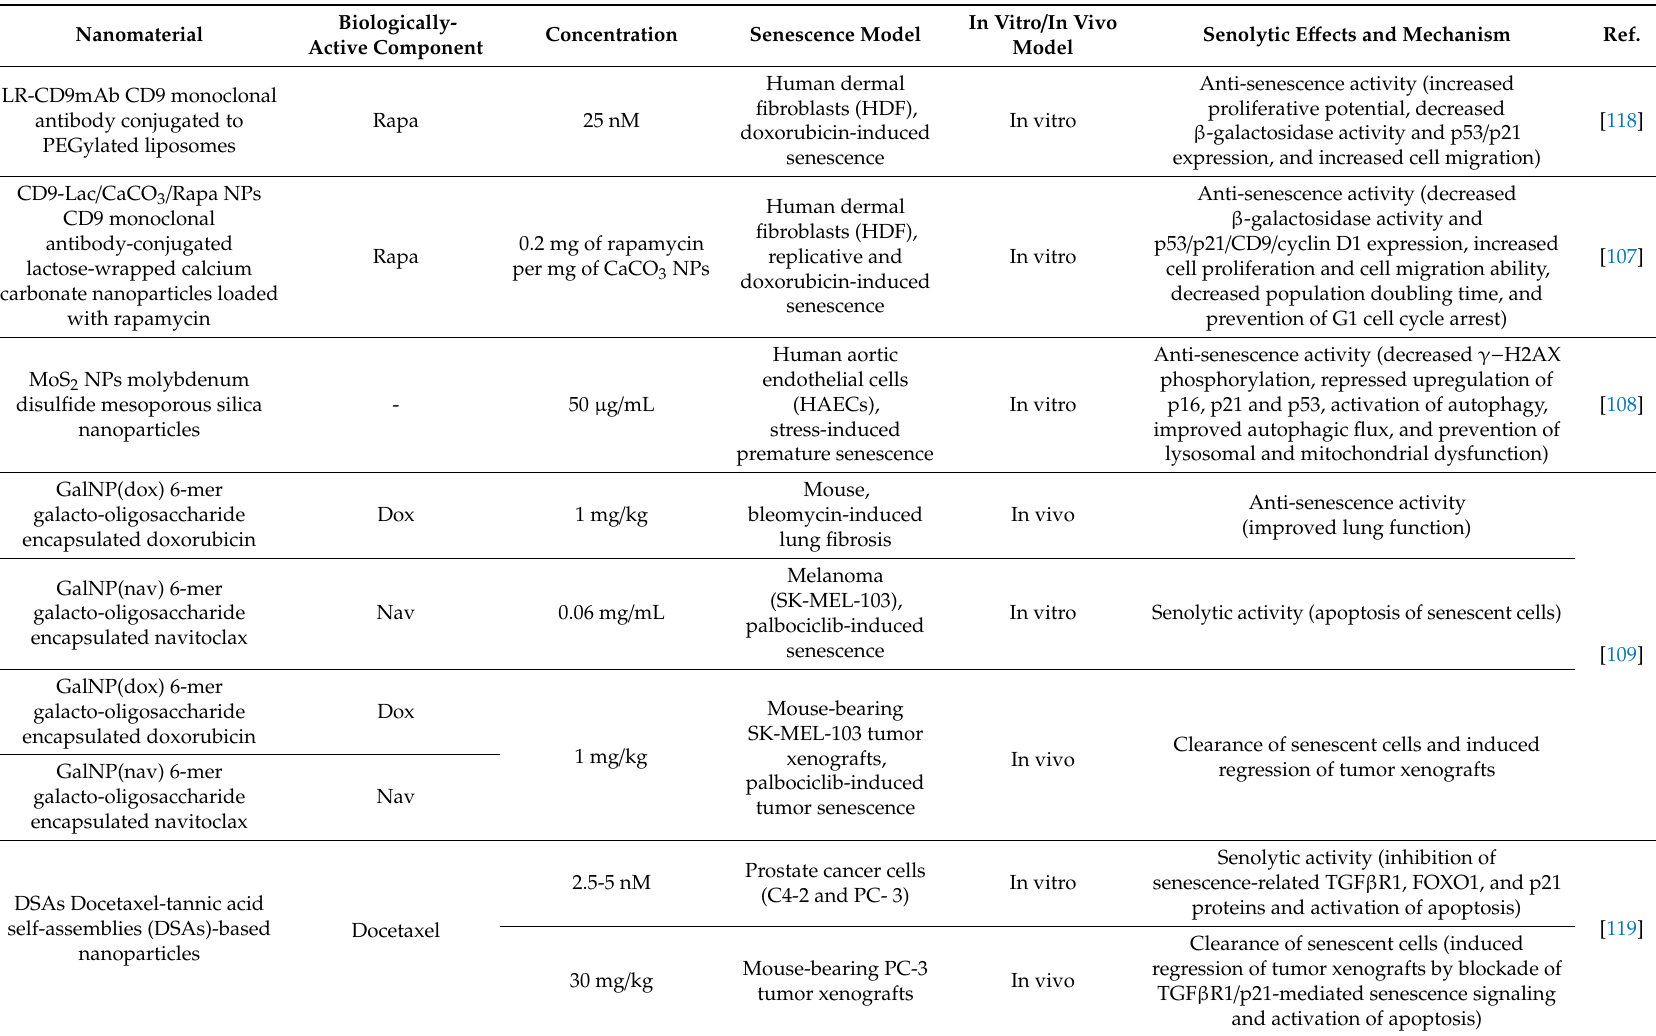
Table 1. Nanomaterials targeting senescent cells using cellular in vitro and in vivo